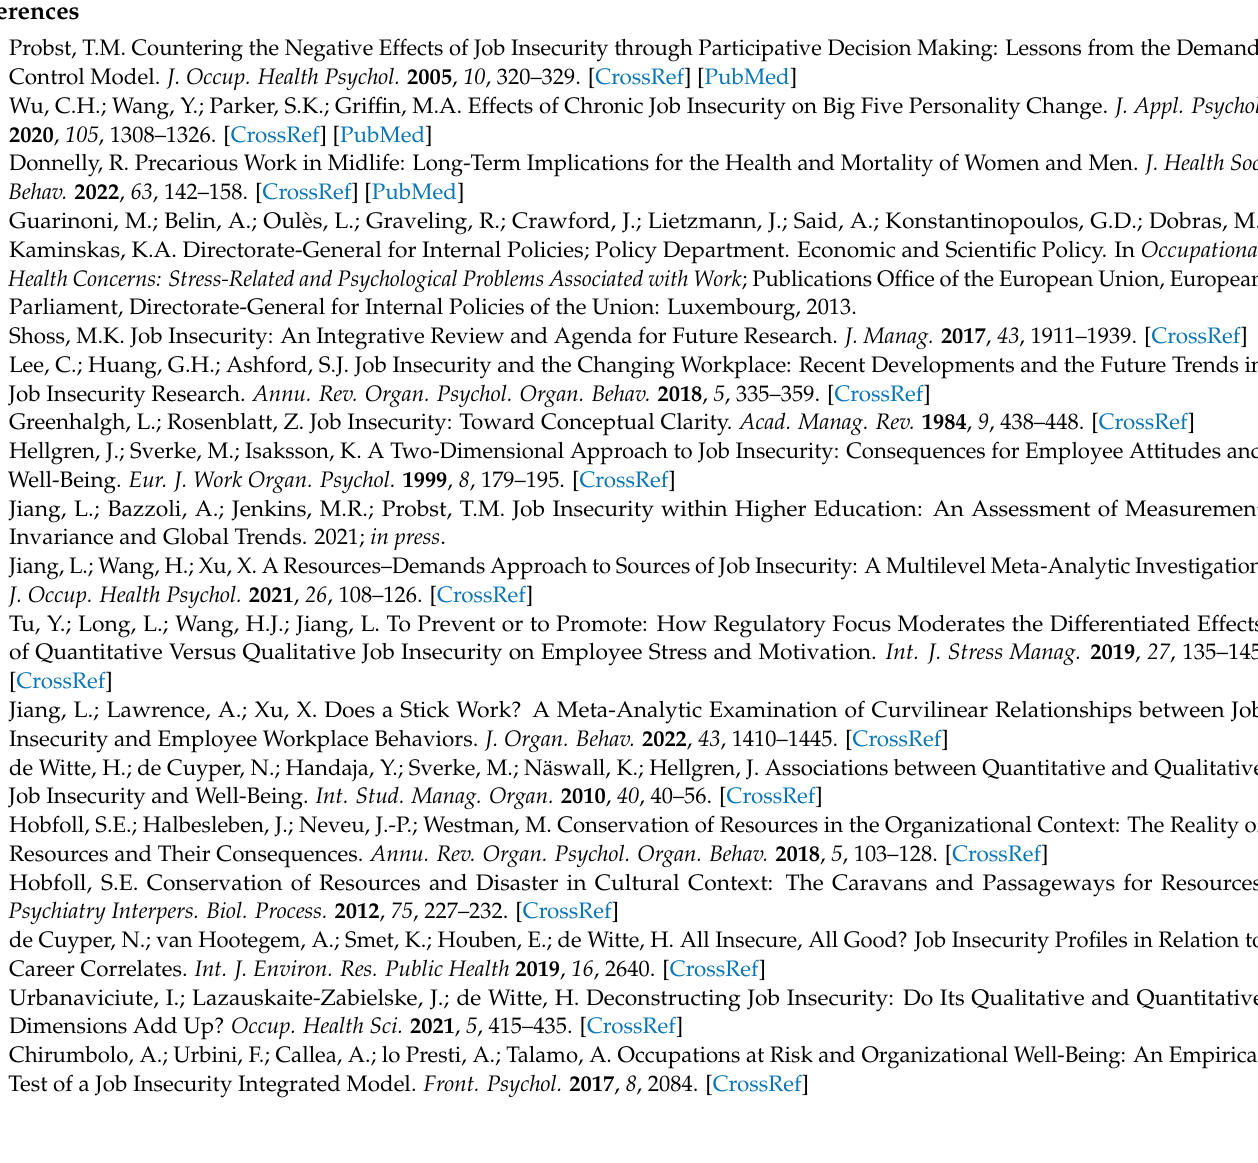
Figure A8. Organization. Figure A8.